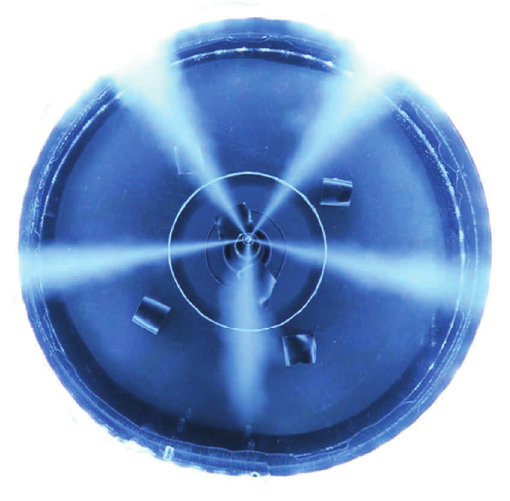
Fig. 20. Fuel spray pattern of a damaged